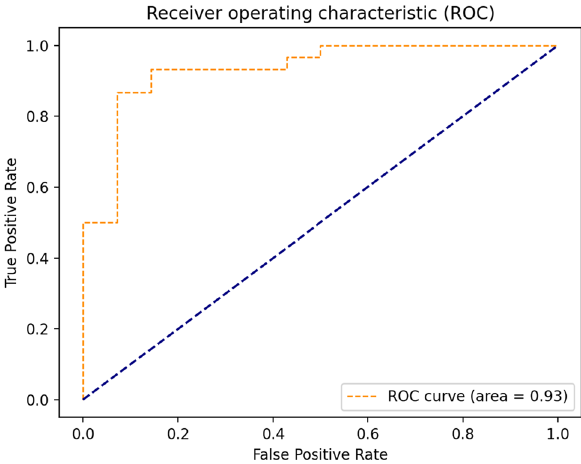
Figure 5. The ROC curve of DF-COVID-19 for the test set.